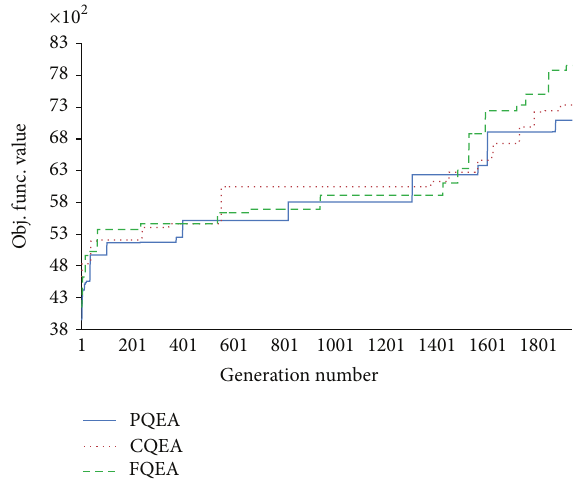
Figure 41: Convergence graph of PQEA, CQEA, and FQEA on 0-1 knapsack problem circle data instances with number of items, 𝑀 , being 200 and capacity, 𝐶 , being 1% of total weight.